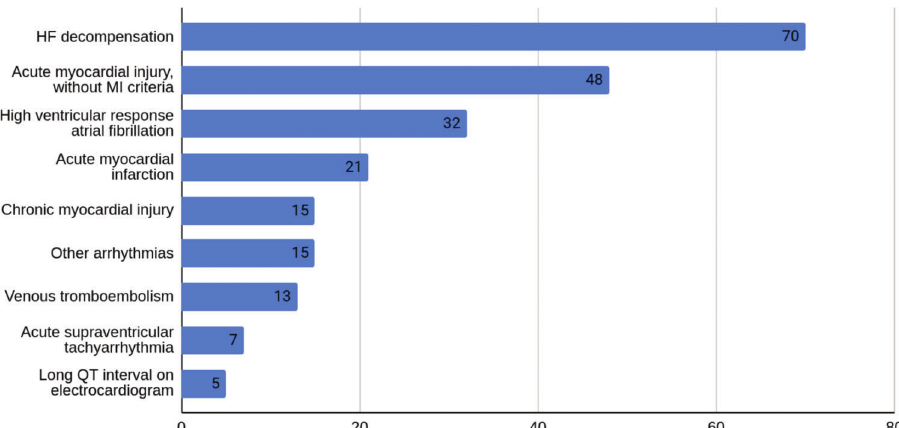
Figure 2 - Cardiovascular manifestations in patients diagnosed with COVID-19. HF: heart failure, MI: myocardial infarction. Data labels display absolute number of patients.